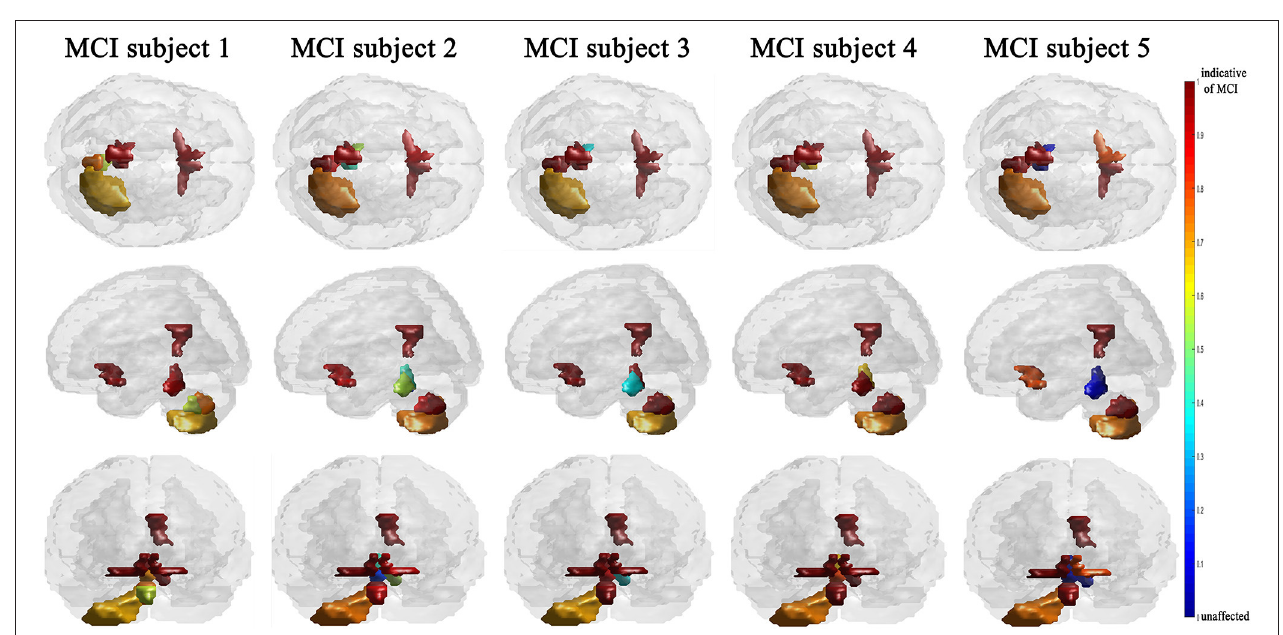
FIGURE 5 | Examples of local diagnosis results of different MCI subjects.